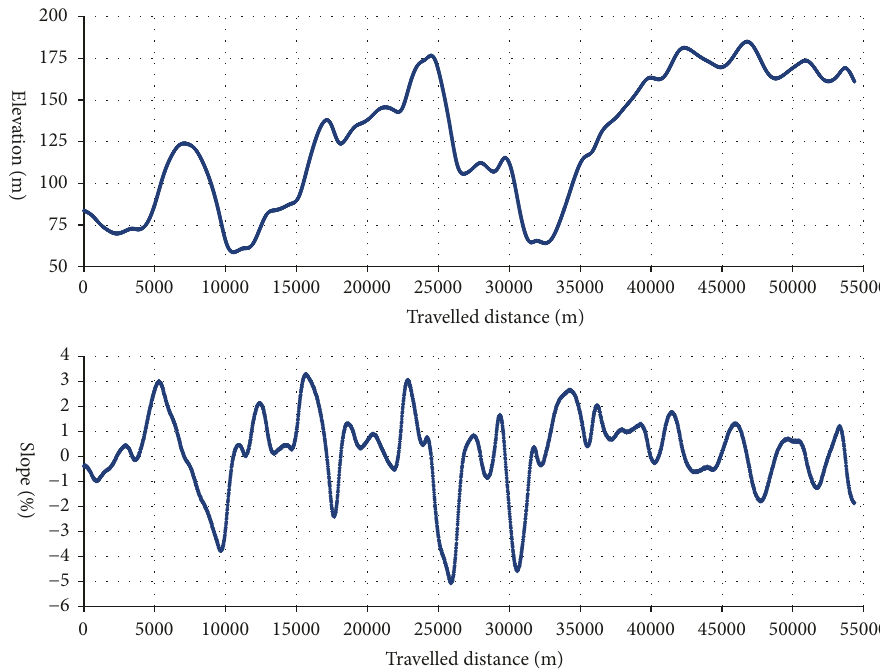
Figure 2: Top panel: the road between the two cities of G¨oteborg and Bor˚as in Sweden. Bottom panel: the slope variation of the same road.